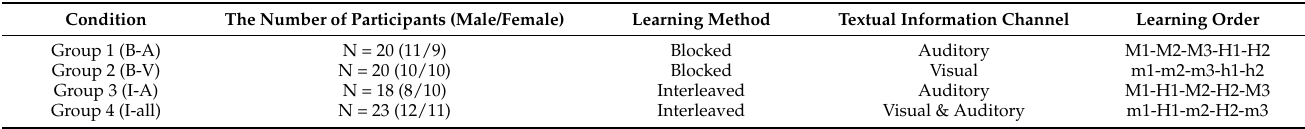
Table 1. Four learning conditions/groups in the formal